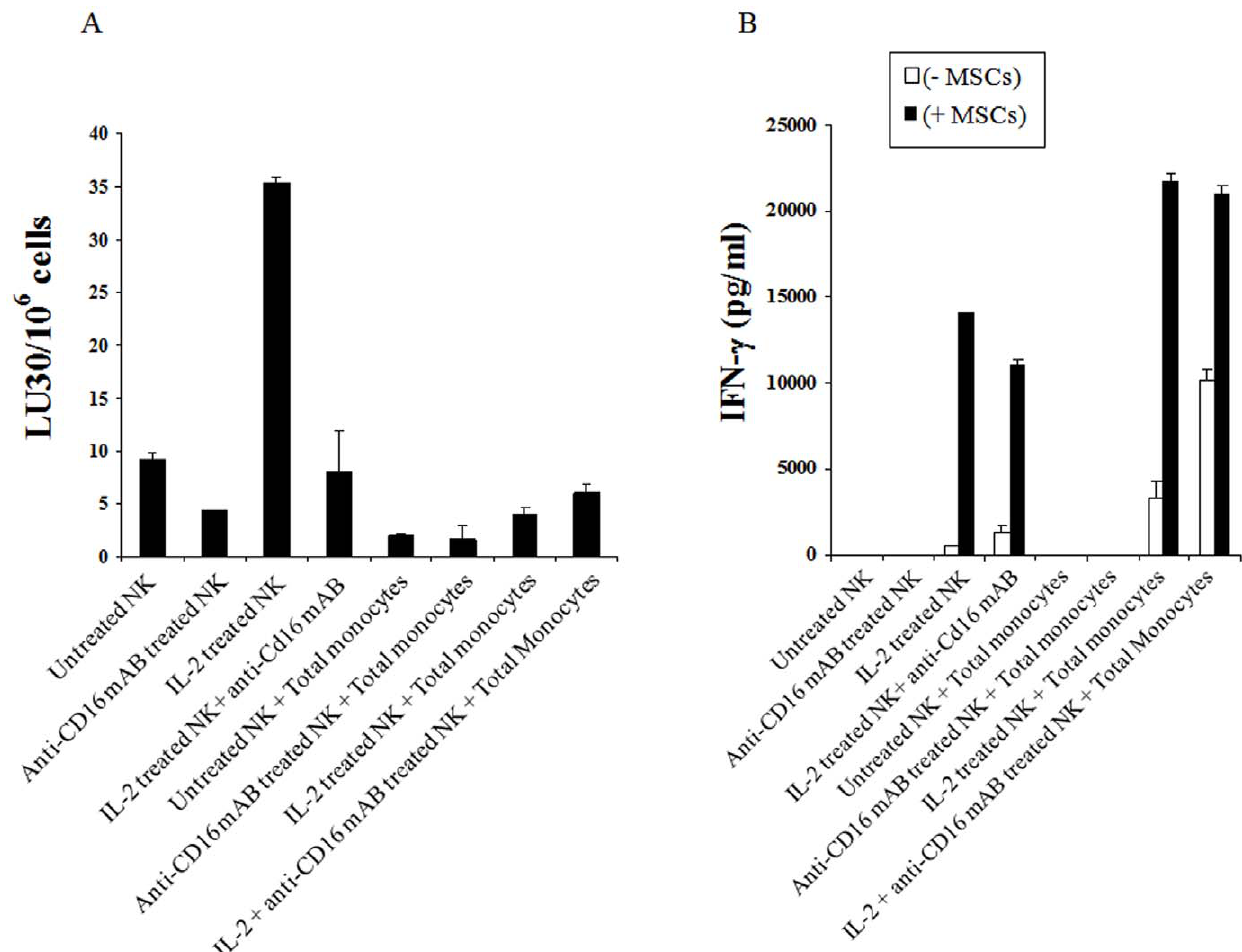
Figure 4. Monocytes decrease the lysis of hMSCs by the NK cells, but significantly augment the secretion of IFN- c in the co-cultures of NK, monocyte and hMSCs. HMSCs (1 6 10 6 cells/plate) were cultured with the irradiated monocytes (10 Gy) (monocyte: MSC ratio of 1:1) for 24– 48 hours before they were removed from the plates, washed and labeled with 51 Cr and used as targets in the cytotoxicity assays against NK cells. The NK samples were either left untreated or treated with anti-CD16 mAb (3 m g/ml), IL-2 (1000 u/ml), or a combination of IL-2 (1000 u/ml) and anti-CD16 mAb (3 m g/ml) for 24–48 hours before they were added to 51 Cr labeled hMSCs at different effector to target (E:T) ratios. Supernatants were removed after 4 hours of incubation and the released radioactivity counted by a b counter. % cytotoxicities were determined at different E:T ratio, and LU 30 / 10 6 cells were calculated using the inverse of the number of effectors needed to lyse 30% of the hMSCs 6 100.. One of three representative experiments is shown in this figure ( A ). hMSCs (1 6 10 5 cells/well) were co-cultured with and without irradiated Monocytes at 1:1 hMSCs to monocytes for 24–48 hours before untreated or IL-2 (1000 u/ml) pre-treated or anti-CD16 mAb (3 m g/ml) pre-treated, or a combination of IL-2 (1000 u/ml) and anti-CD16 mAb (3 m g/ml) pre-treated NK cells at 1:1:1 NK:monocyte:hMSC ratios were added. NK cells were pre-treated as indicated for 24–48 hours before they were added to the co-cultures of monocytes and hMSCs. NK samples were also cultured in the absence of monocytes and hMSCs. After 24–48 hours of the addition of NK cells the supernatants were removed from the cultures and the levels of IFN- c secretion were determined using a specific ELISA. One of five representative experiments is shown in this figure ( B ).